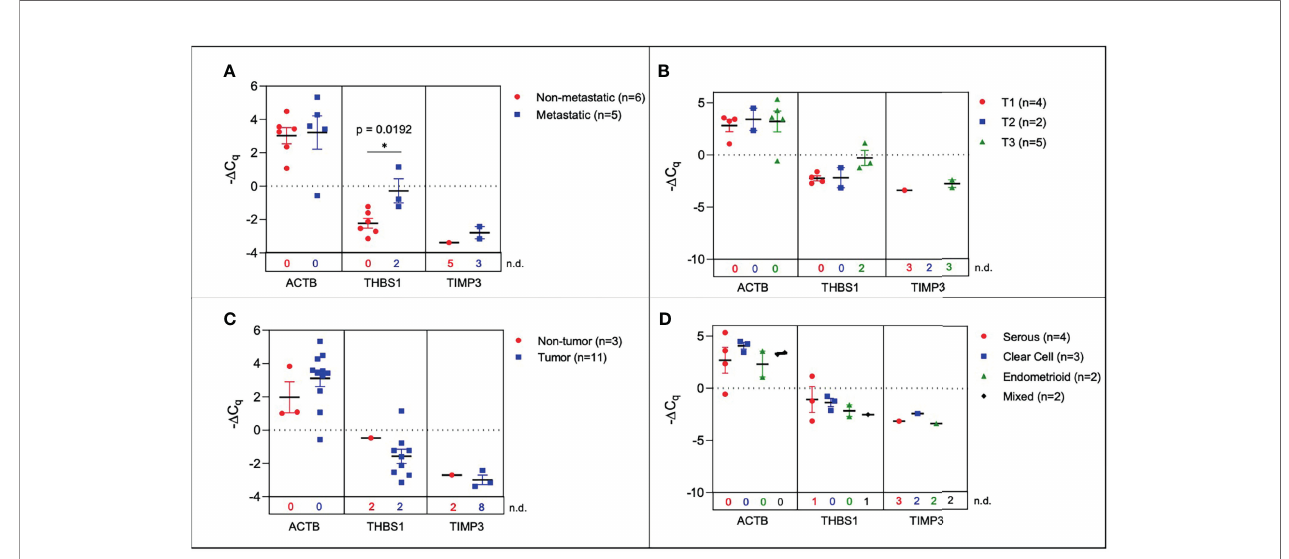
FIGURE 4 | Plasma-derived sEV gene expression in human samples. Scatter plots of D Cq values comparing (A) serum from metastatic and non-metastatic samples, (B) samples strati fi ed by TNM staging (C) tumor-bearing and non-tumor-bearing samples, and (D) samples strati fi ed by histology. P values indicated were determined via unpaired two-tailed t-test. The number of non-detected (n.d.) C q values in each experimental group are listed underneath the corresponding scatter plots. *p<0.05, **p<0.01, ***p<0.001,